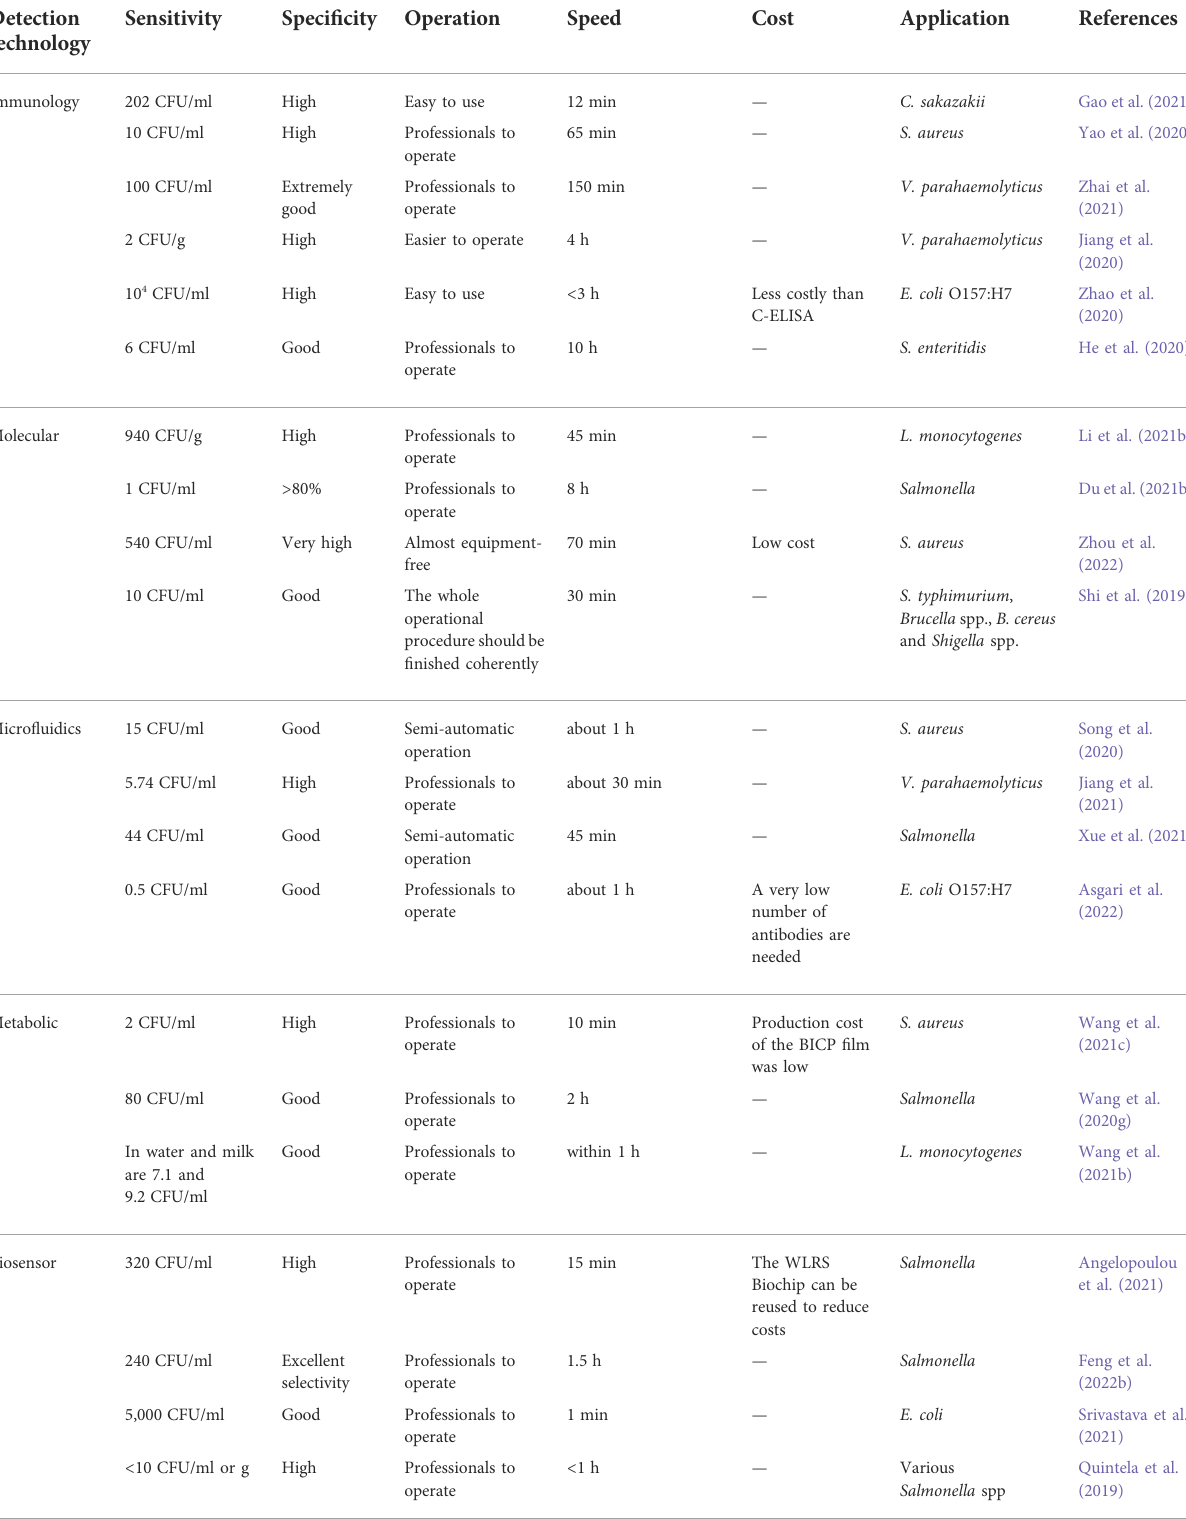
TABLE 1 Compare the methods of detecting foodborne